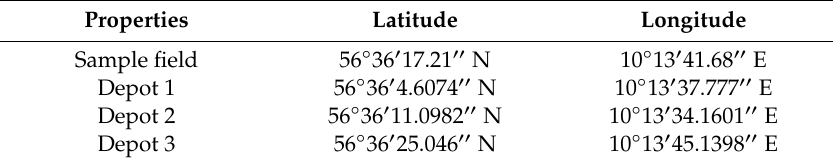
Table 4. Properties of the case study field (size = 16